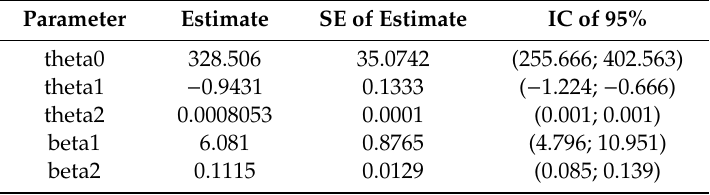
Table 3. Parameter calculations associated with Cu dissolution model.